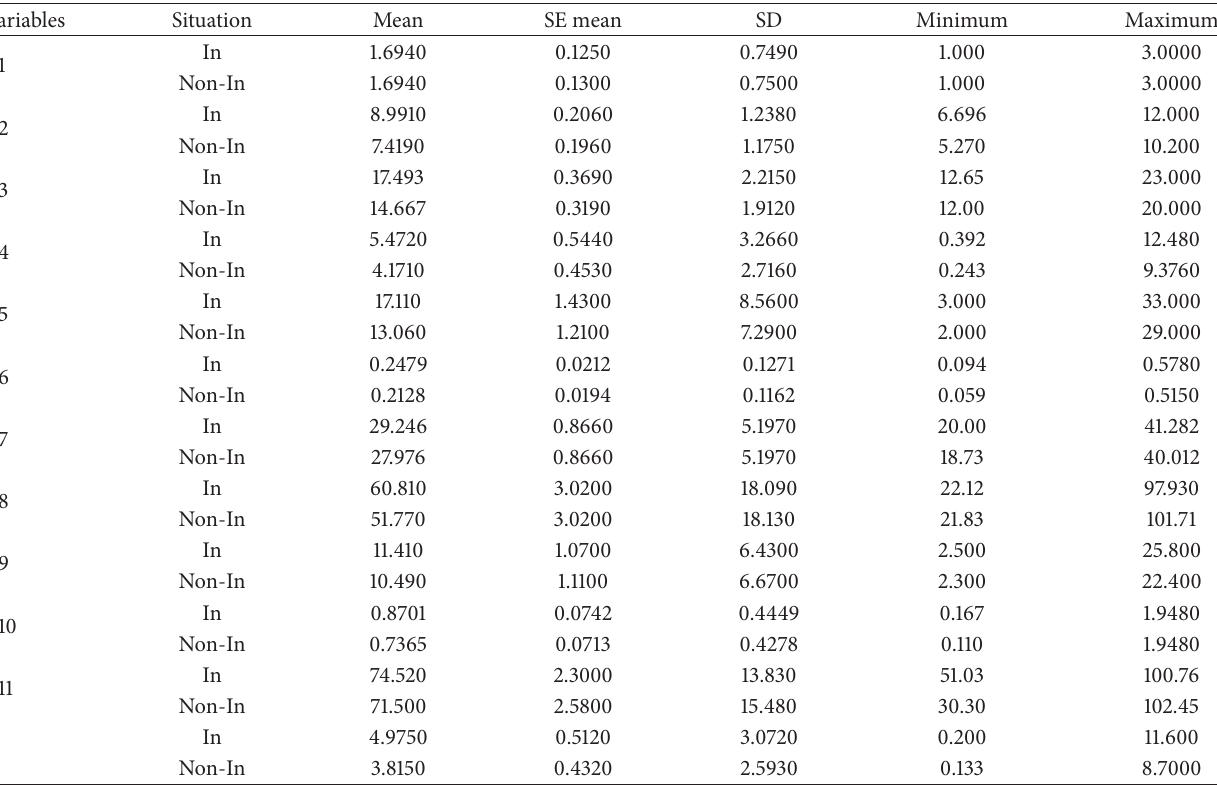
Table 1: Basic statistics (minimum and maximum values, arithmetic mean, standard deviation (SD) and standard error of mean (SE mean)) for the measured variables of wheat under inoculation (In) and noninoculation (non-In) conditions and different water